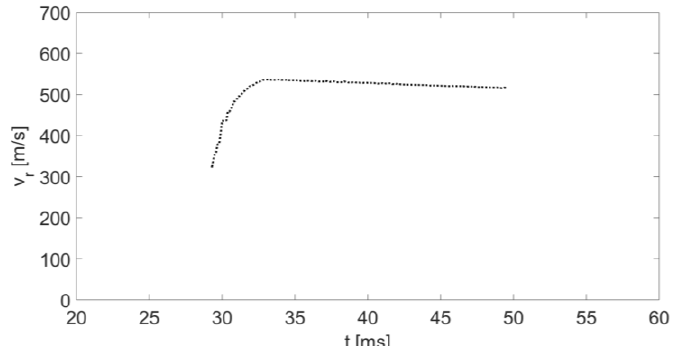
Figure 15. The instantaneous velocity of the fired bullet as a function of time. Sensors 2020 , 20 , x FOR PEER REVIEW